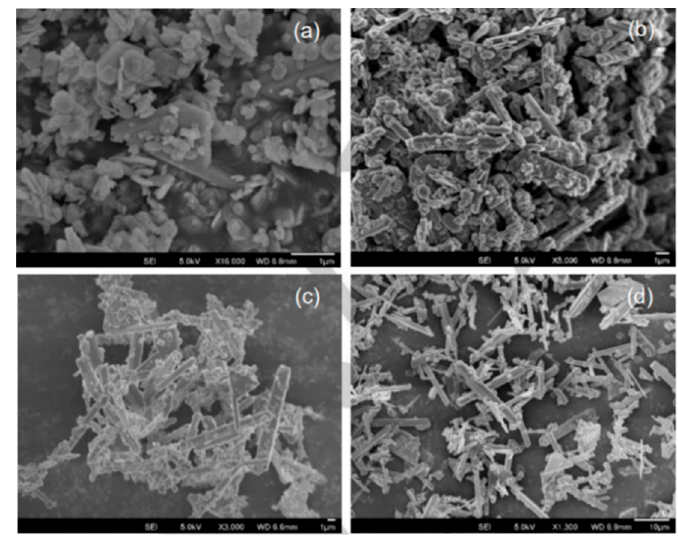
Figure 3. SEM images of α -ZrP prepared by the minimal solvent synthesis method with F − ions at different reaction times; ( a ) 1 h ( b ) 4 h ( c ) 8 h and ( d ) 96 h. Reproduced from [40], with permission from John Wiley and Sons, 2017.